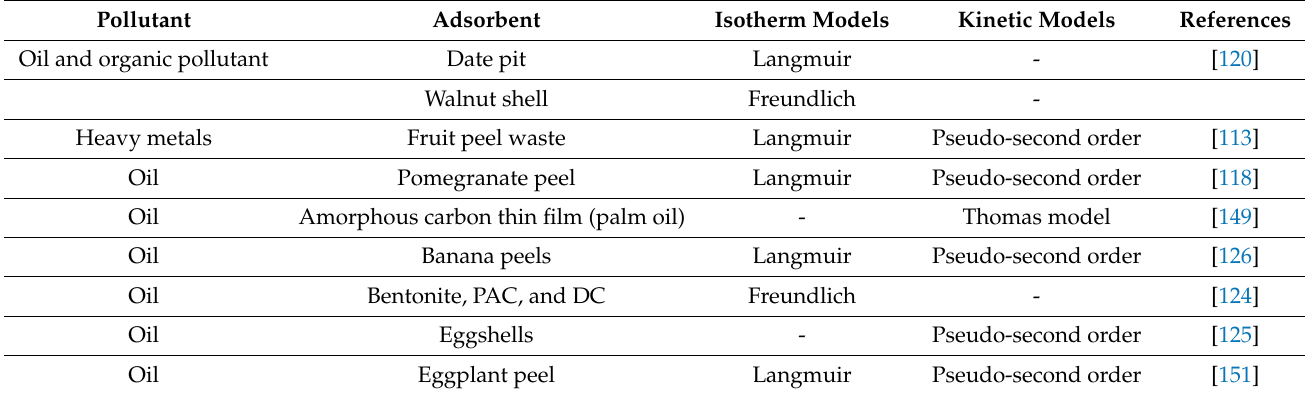
Table 6. Adsorption isotherms and kinetics models for the adsorption of contaminants from produced